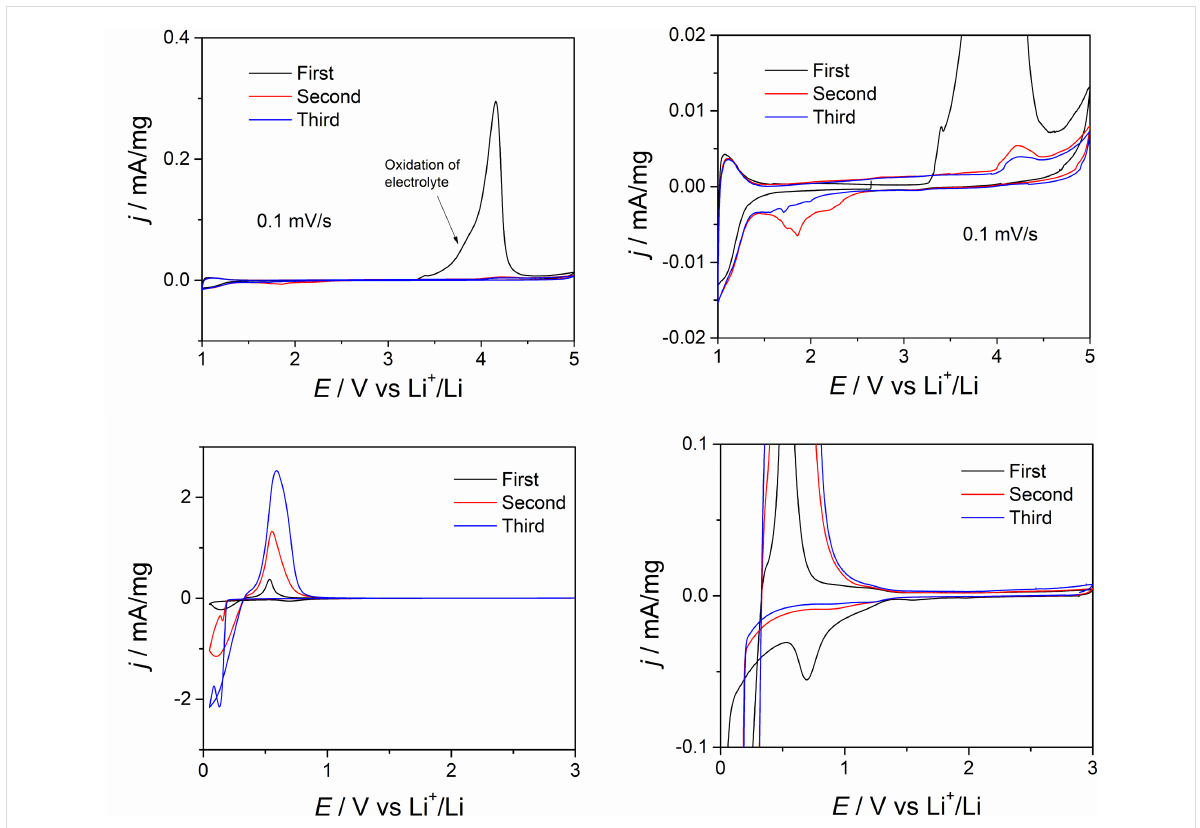
Figure 5: Cyclic voltammetry of a half-cell with ErF 3 as working electrode and lithium foil as counter electrode at the different cut-off potentials. The figures at the right represent magnifications of the two left figures.